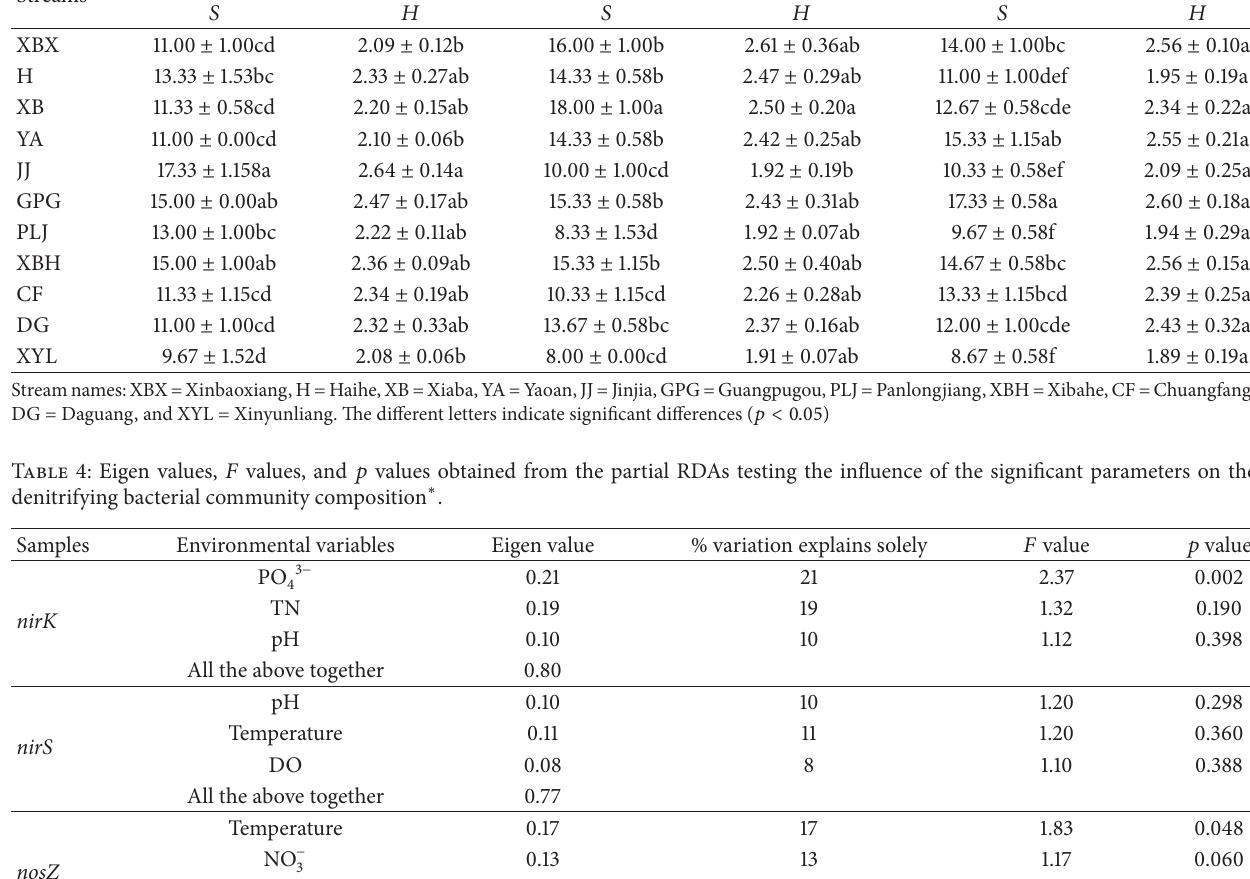
Table 3: Shannon index ( 𝐻 ) and richness ( 𝑆 ) values of nirK , nirS , and nosZ genes. Streams